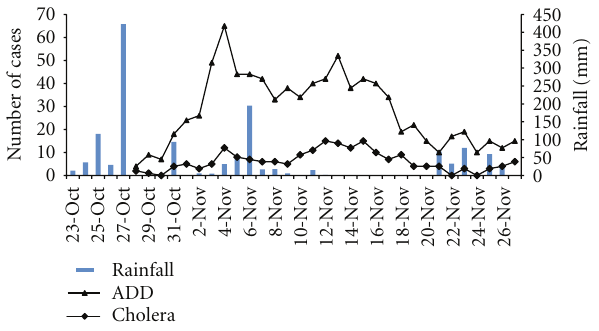
Figure 2: Daily number of patients with acute diarrheal disease (ADD) including cholera and confirmed daily number of cholera cases admitted to Communicable Disease Hospital, Chennai, India, between Oct 27 and Nov 26, 2005. The daily rainfall is overlaid with the illness cases as bar graph. The first peak of illness was observed eight days after the first heavy rain storm on Oct. 27th. The second illness peak was found seven days after the second major rain storm on Nov.